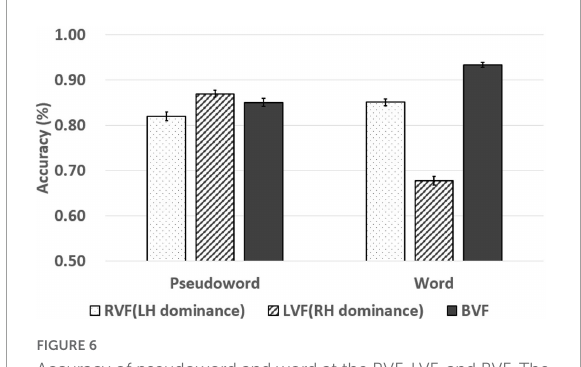
FIGURE6 Accuracy of pseudoword and word at the RVF, LVF, and BVF. The line in the bar graph denotes the range of standard